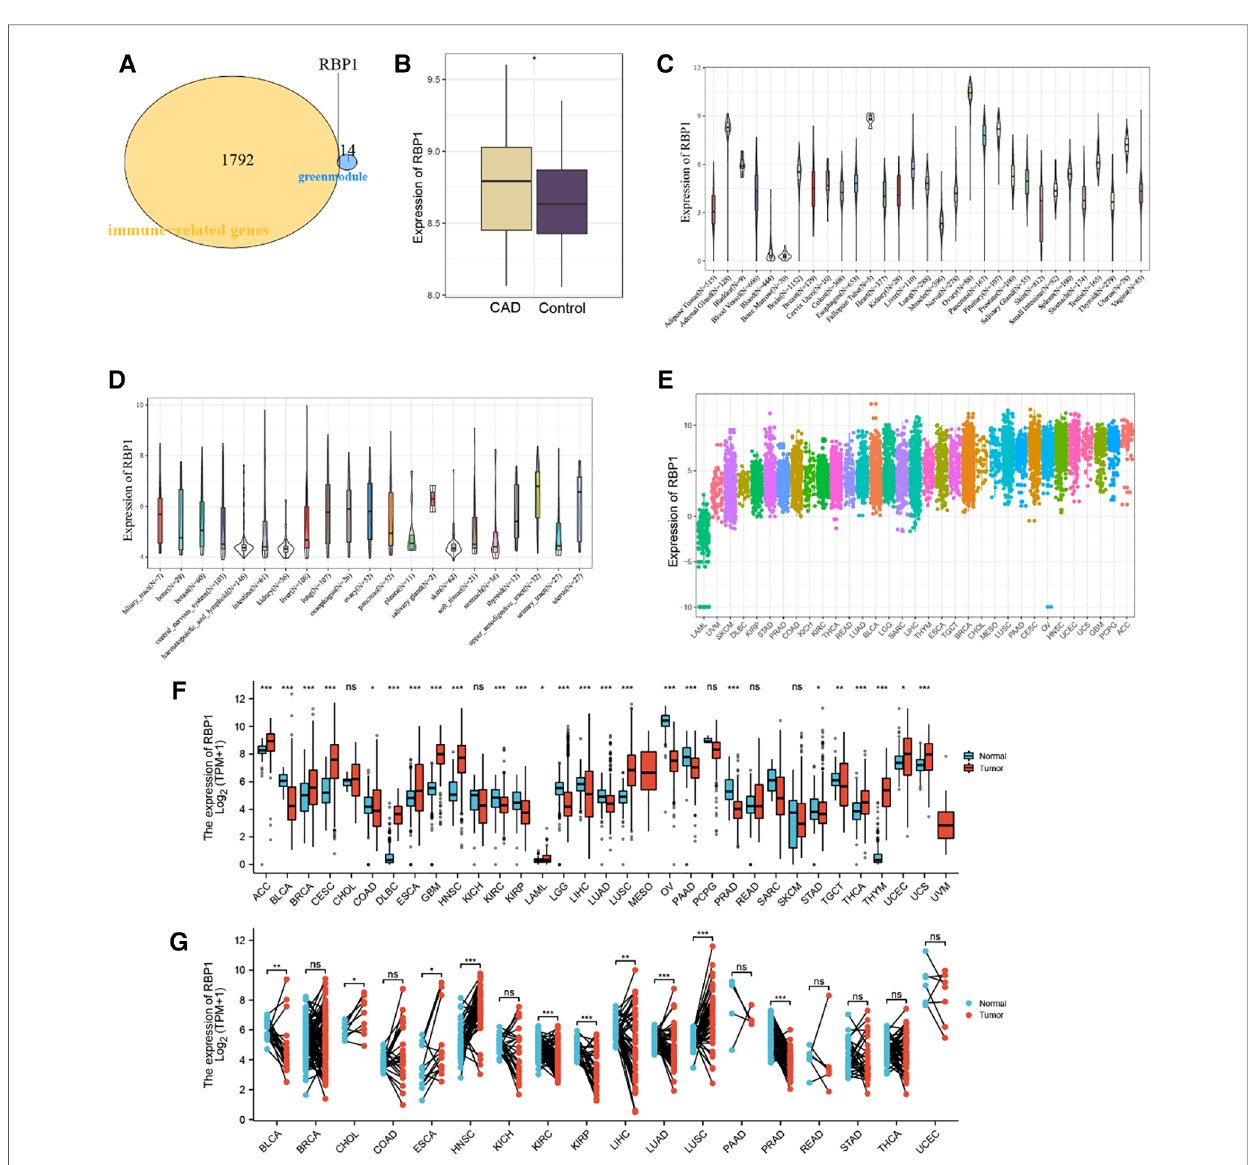
FIGURE 3 Identi fi cation and expression level analysis of immune-related hub genes. ( A ) Venn diagram showing RBP1 as an intersection gene of immune-related genes and green module. ( B ) Expression level of RBP1 in CAD and control. ( C ) RBP1 expression levels in healthy tissues are listed in the GTEx database. ( D ) Tumor cell lines in the CCLE database ’ s RBP1 expression levels. ( E ) RBP1 expression in tumor tissues, according to the TCGA database. ( F ) The merging of data from the GTEx database and TCGA for the tumor tissues has shown the RBP1 expression levels in tumor tissues and normal tissues. ( G ) RBP1 expression levels in TCGA database paired with normal and tumor tissues expression